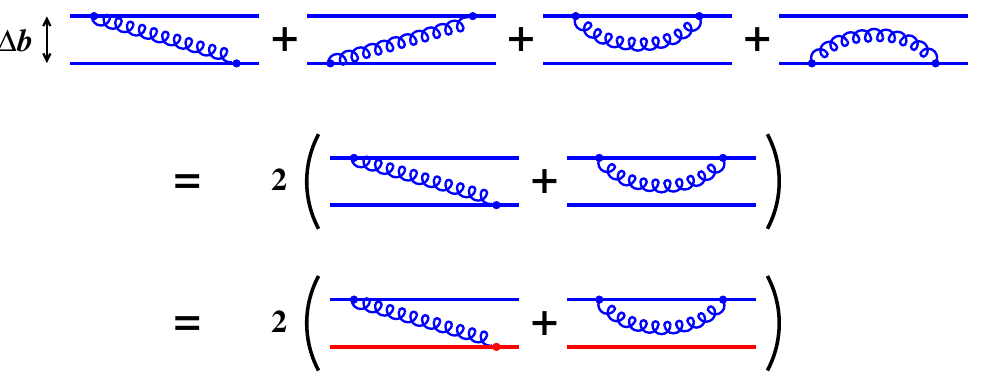
Figure 12 . Similar to the diagrams of figure 7 for the LMW correction, but here both Wilson lines are amplitude (blue)